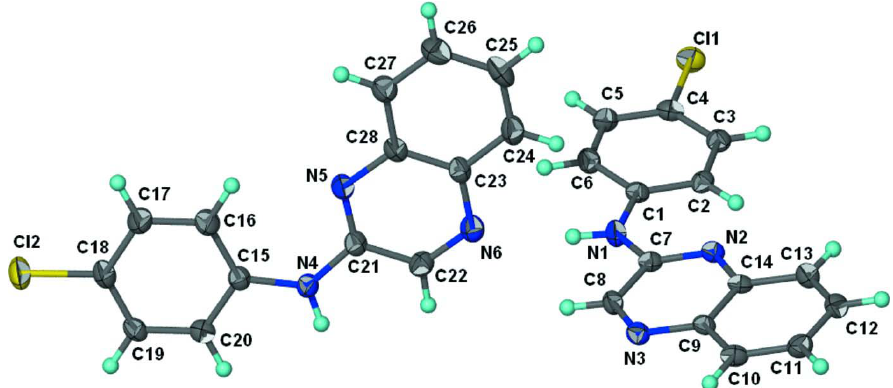
The molecular structure of (I) at the 70% probability level; hydrogen atoms are drawn as spheres of arbitrary radius. 2-(4-Chloroanilino)quinoxaline Crystal